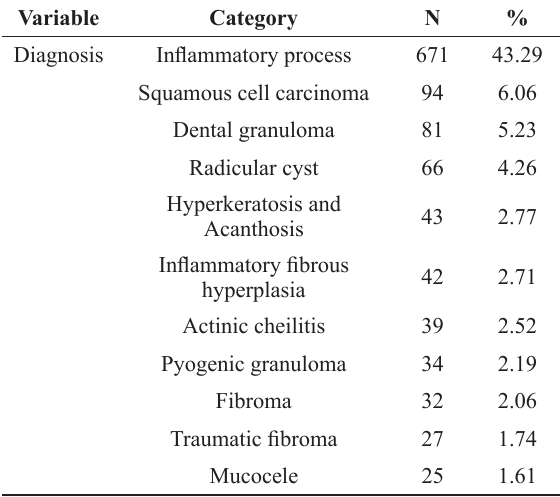
Absolute and relative frequency of diagnosed